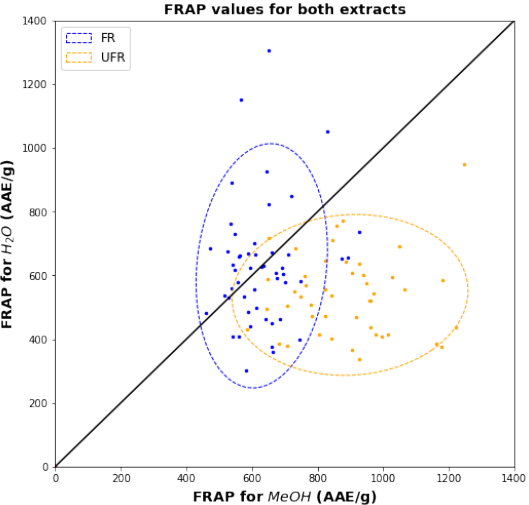
Figure 6. Scatter diagram showing FR and UFR FRAPs for water versus